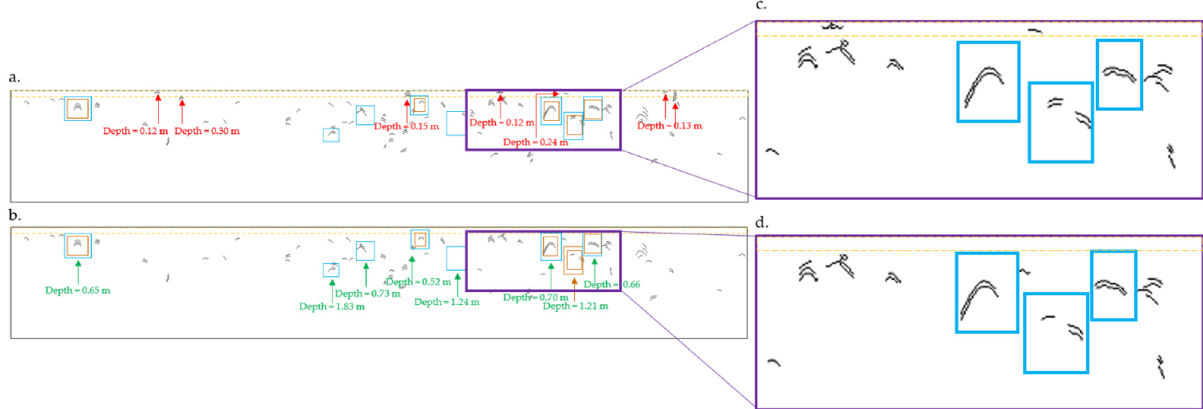
Figure 13. The result of introducing the condition of the depth of the object: ( a ) target image before introducing the C D condition; ( b ) image after introducing the C D condition. ( c ) Magnified fragment of Figure 13a; ( d ) magnified fragment of Figure 13b.